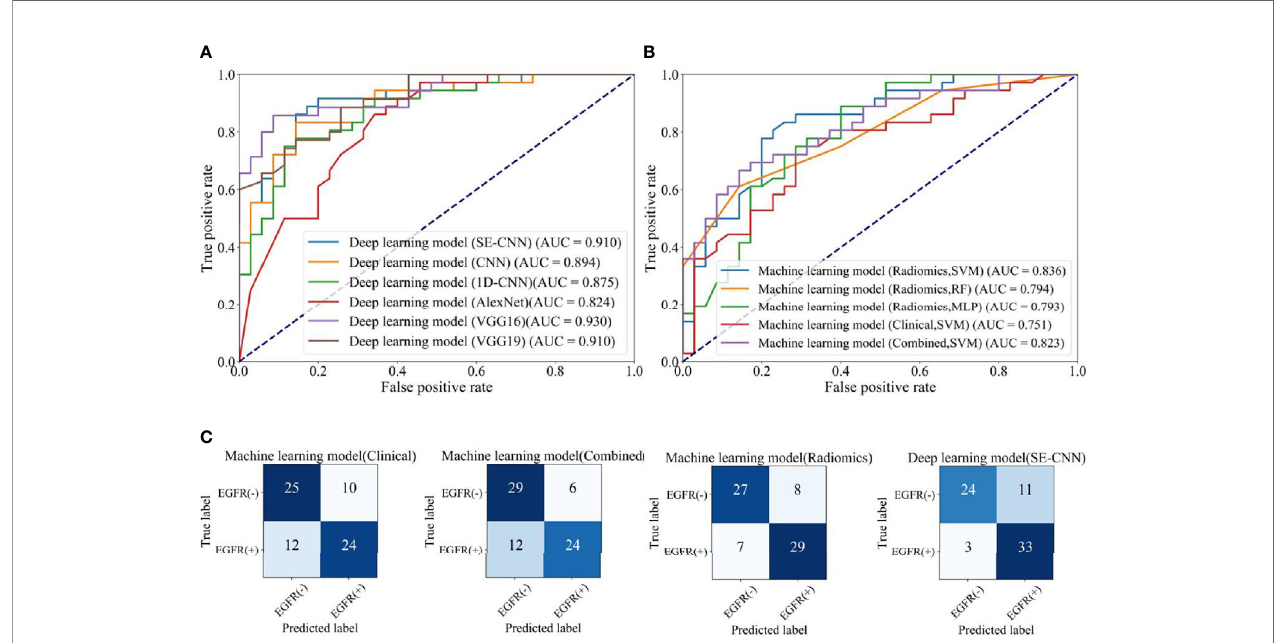
FIGURE 5 | The EGFR status recognition performance of different models for the internal test cohort (71 of 709 patients). (A) ROC curves of different deep learning models. (B) ROC curves of machine learning models using clinical features, radiomics features (SVM, RF, MLP), and combined features. (C) Confusion matrix of